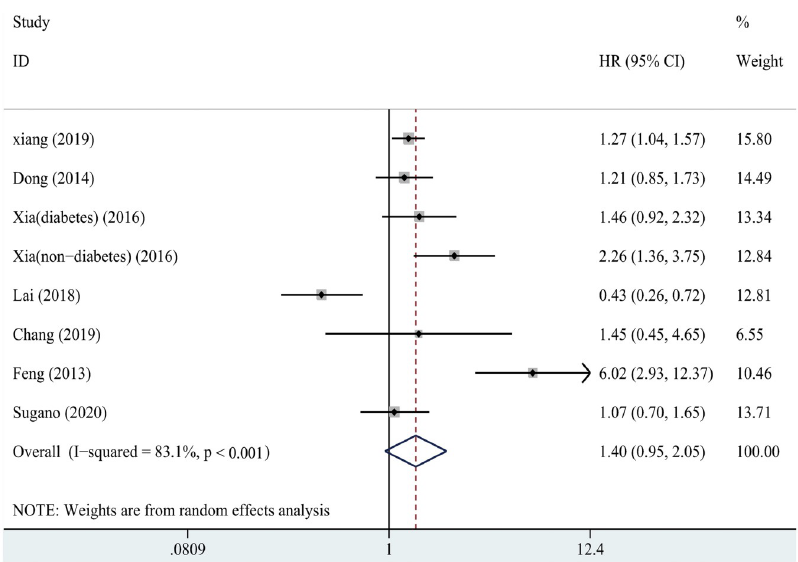
Fig 4. Forest plot about the relationship between SUA and all-cause mortality in PD patients. SUA, serum uric acid; PD, peritoneal